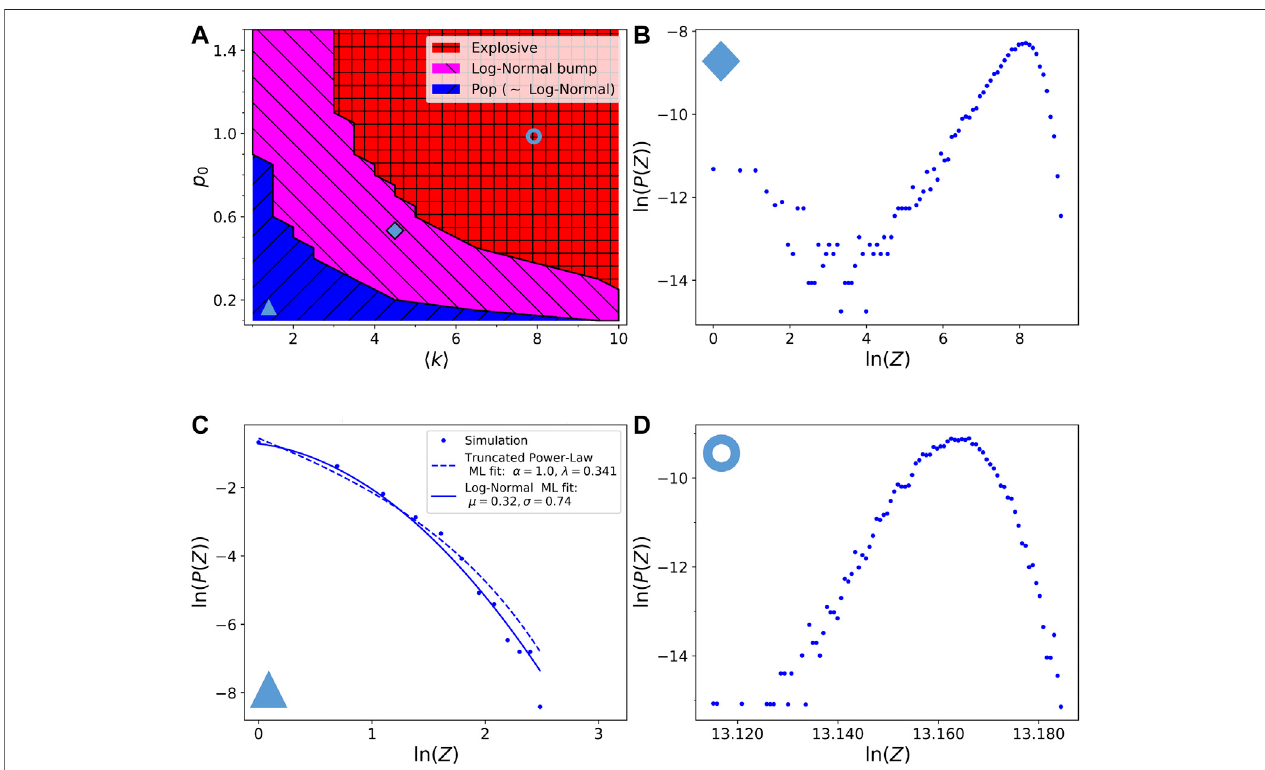
FIGURE6|(A) Phasediagramoftheresultingavalanchesizedistributionswithrespecttothemodelparameters 〈 k 〉 and p 0 (see Eq.8 ),inthecaseoflinkrestoring. The time constant is τ (cid:1) 4 and the rheological exponent is α (cid:1) 0 . 3. Symbols indicate the points taken to show some distribution examples in the remaining panels. The pop (blue) and explosive (red) regimesare the same asin Figure 3 , while the log-normal bump regime iscomposed ofapproximately log-normally distributed avalanche sizes (in magenta), together with some small avalanches reminiscent of the pop regime. Compared to Figure 3 the phase diagram does not show signi fi cant differences. (B) Example distribution of the log-normal bump regime with coordinates at the diamond point ( 4 . 5 , 0 . 55 ) ; (C) Example distribution of the pop regime, with coordinated at the triangle point ( 1 . 5 , 0 . 2 ) . Dots show the simulation distribution and the full (resp. dashed) line shows the maximum of likelihood fi t with a log-normal (resp. truncated power-law) distribution; (D) Example distribution of the explosive regime, with coordinates at the doughnut point ( 8 , 1 )